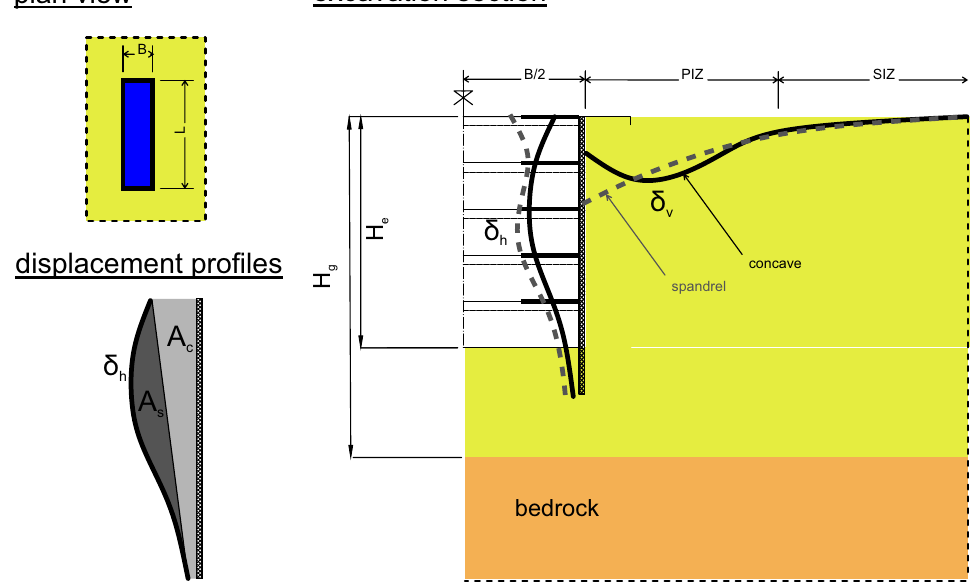
Figure 1. Sketch of the excavation with the main geometric parameters defining the